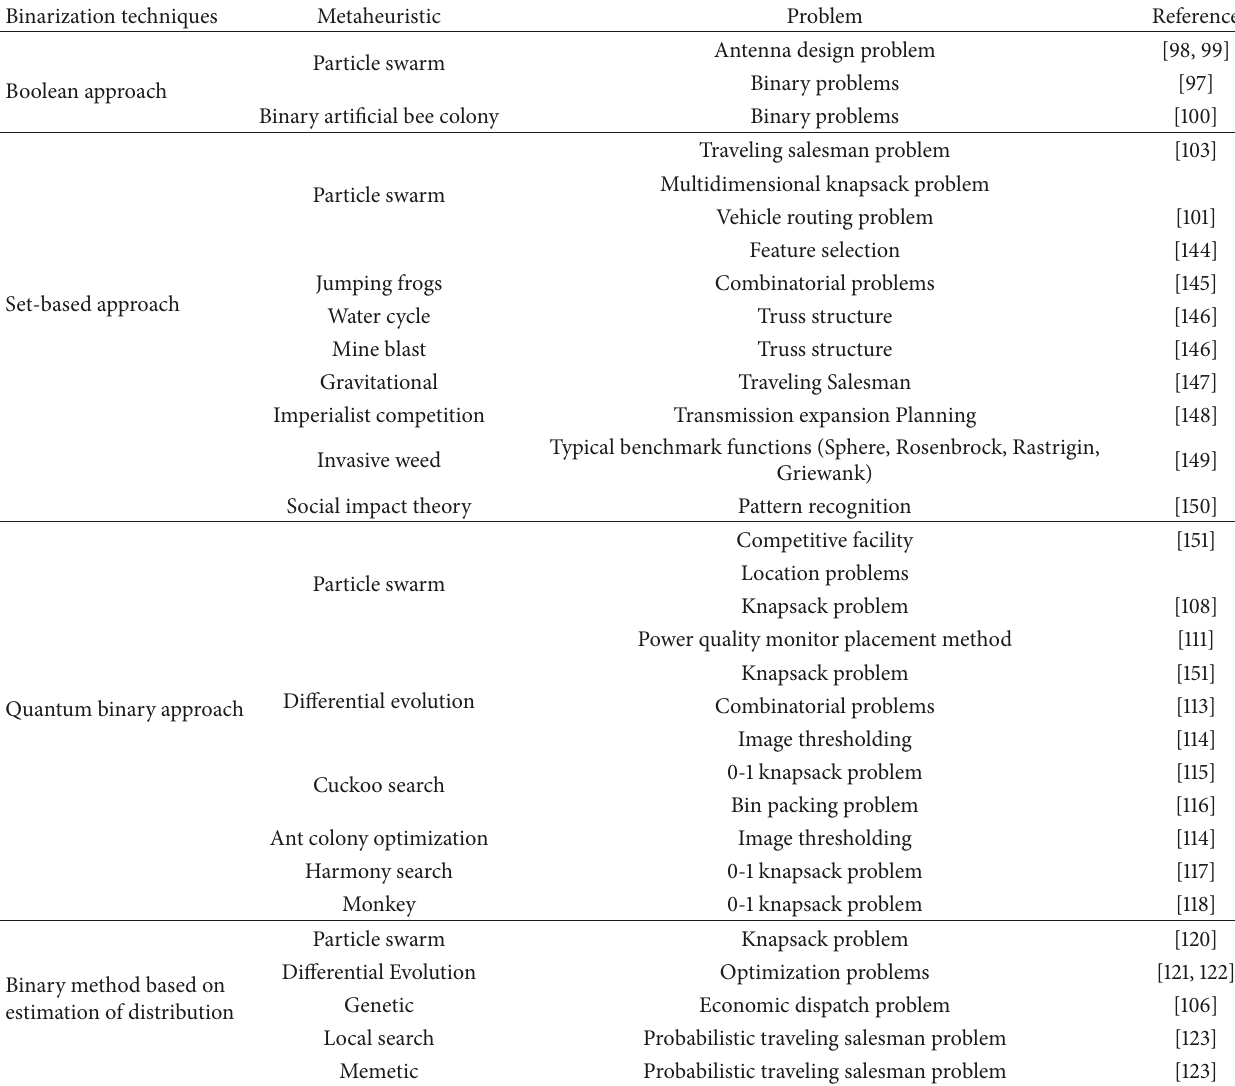
Table 6: Summary of continuous-binary operator